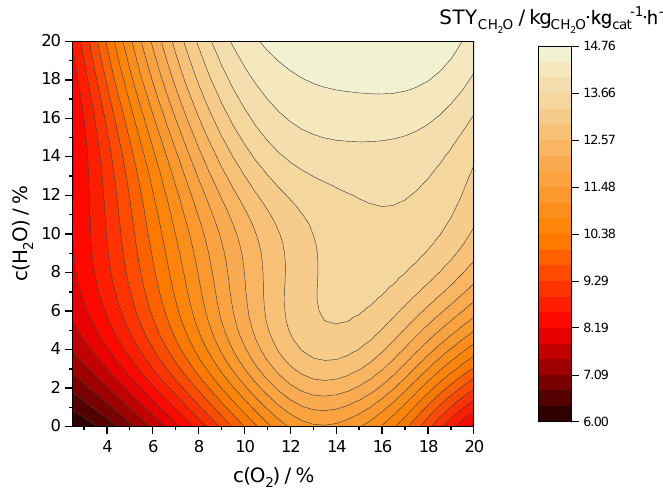
Figure 8. E ff ect of water cofeed and oxygen concentration on formaldehyde space-time yield at 680 ◦ C, 960,000 L · kg − 1 · h − 1 and 0% N 2